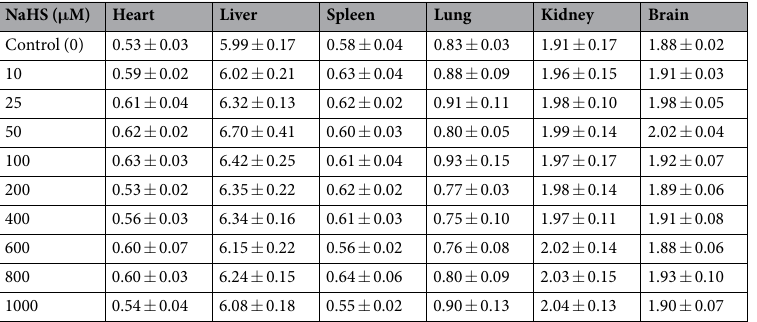
Table 1. Relative organ weight of nude mice bearing SMMC-7721 xenograft after the subcutaneous administration of NaHS for 14 days.